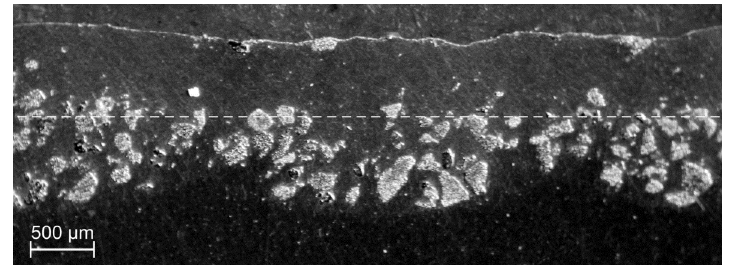
Figure 7. Cross-section through a composite layer based on Al6061 alloy with TiC powder; experimental conditions: I = 400 W/mm 2 , ν sc = 10 mm/s, m p = 6 g/min.